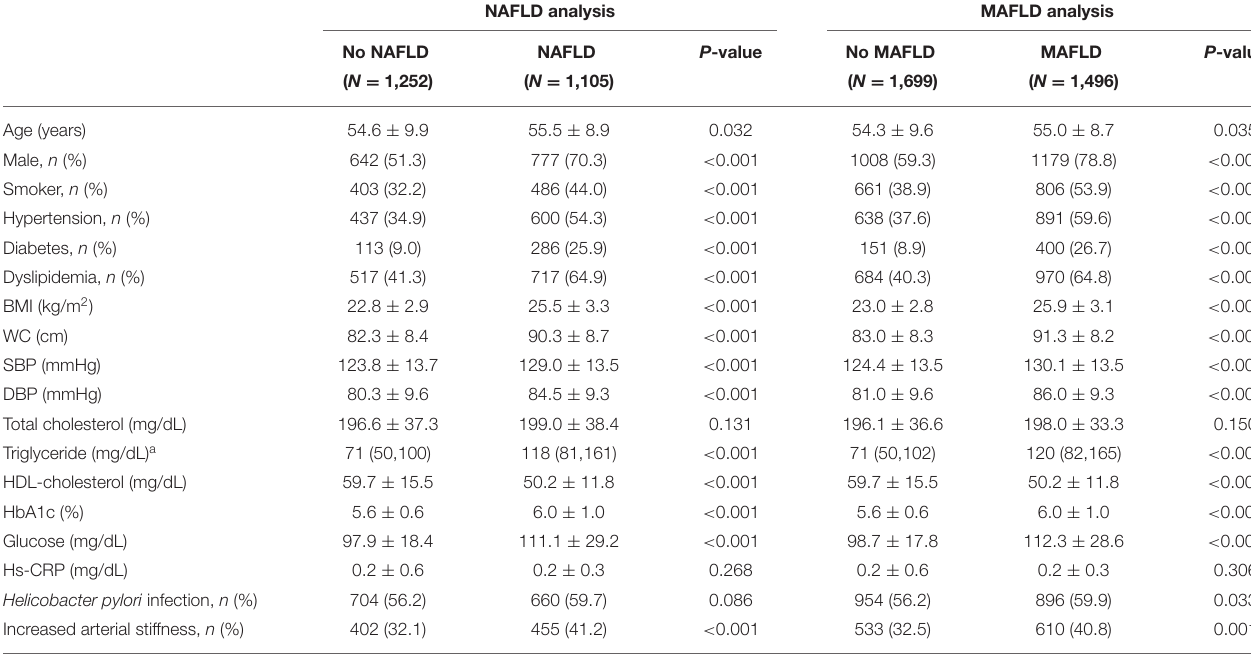
TABLE 1 | Comparison of baseline characteristics according to NAFLD and